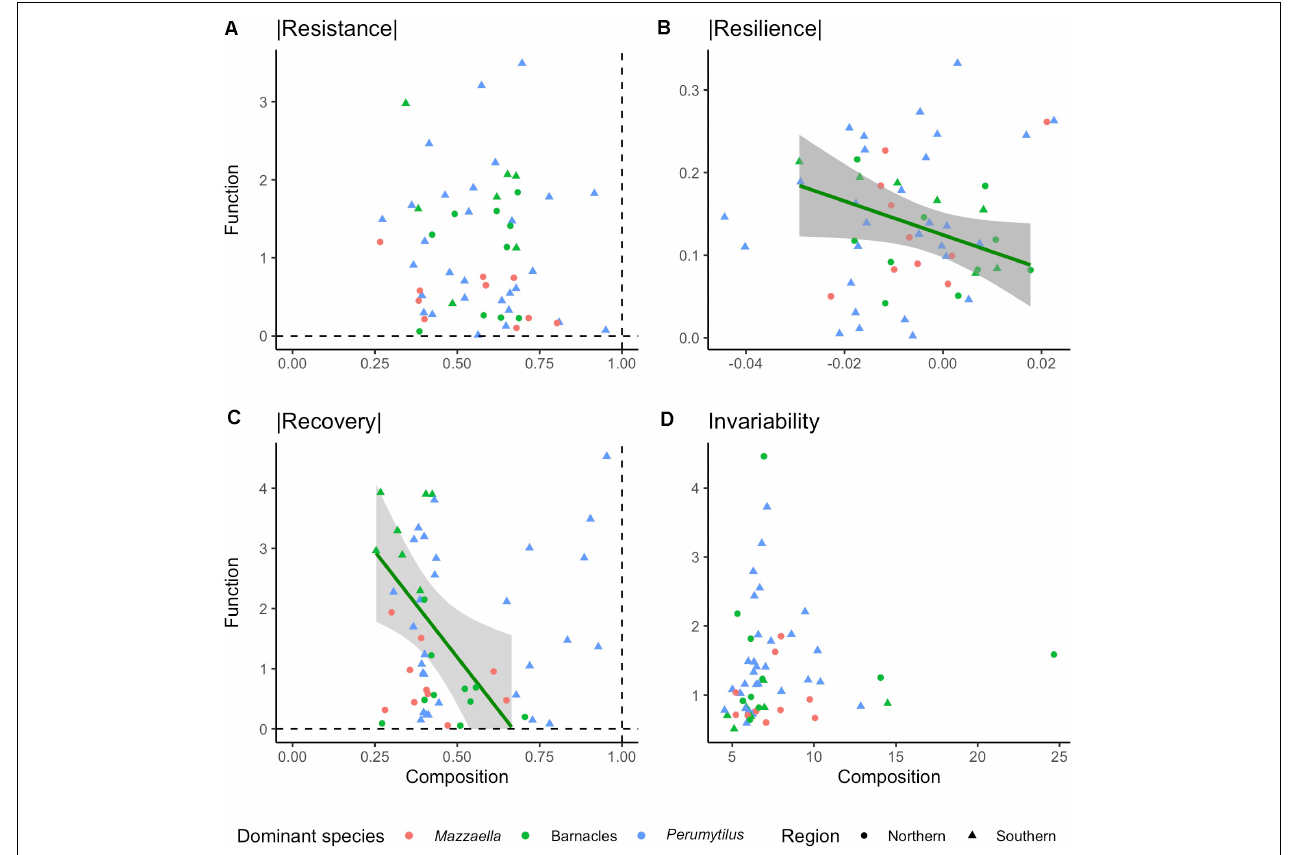
FIGURE 4 | Pairwise associations between functional and compositional (A) resistance, (B) resilience, (C) recovery, and (D) invariability. In these analyses, all functional dimensions were used as absolute values in order to correlated magnitudes, rather that directions of effects. Dashed lines represent maximum resistance and recovery; solid gray lines represent minimum resilience. Only (B) resilience and (C) recovery of the barnacle-dominated communities (green symbols and trend lines ± 95% confidence intervals) showed significant function-composition correlations ( r = − 0.52 and r = − 0.57, respectively; P <